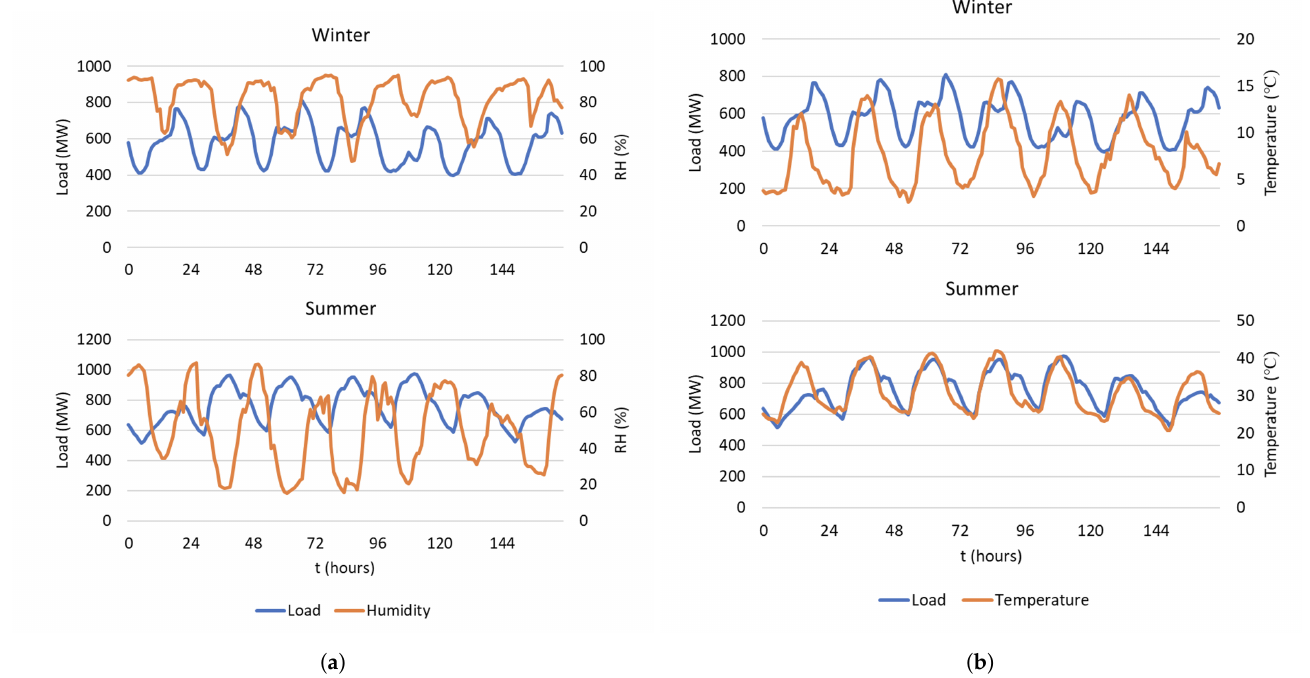
Figure 6. Winter and summer comparisons of hourly load demand and ( a ) relative humidity; ( b )